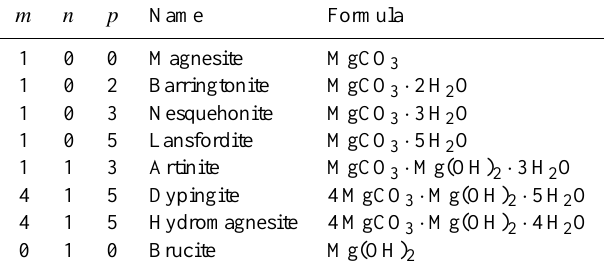
Table 5. Chemical formula of various Mg-Ca carbonates (the numbers m , n and p correspond to the following formula: